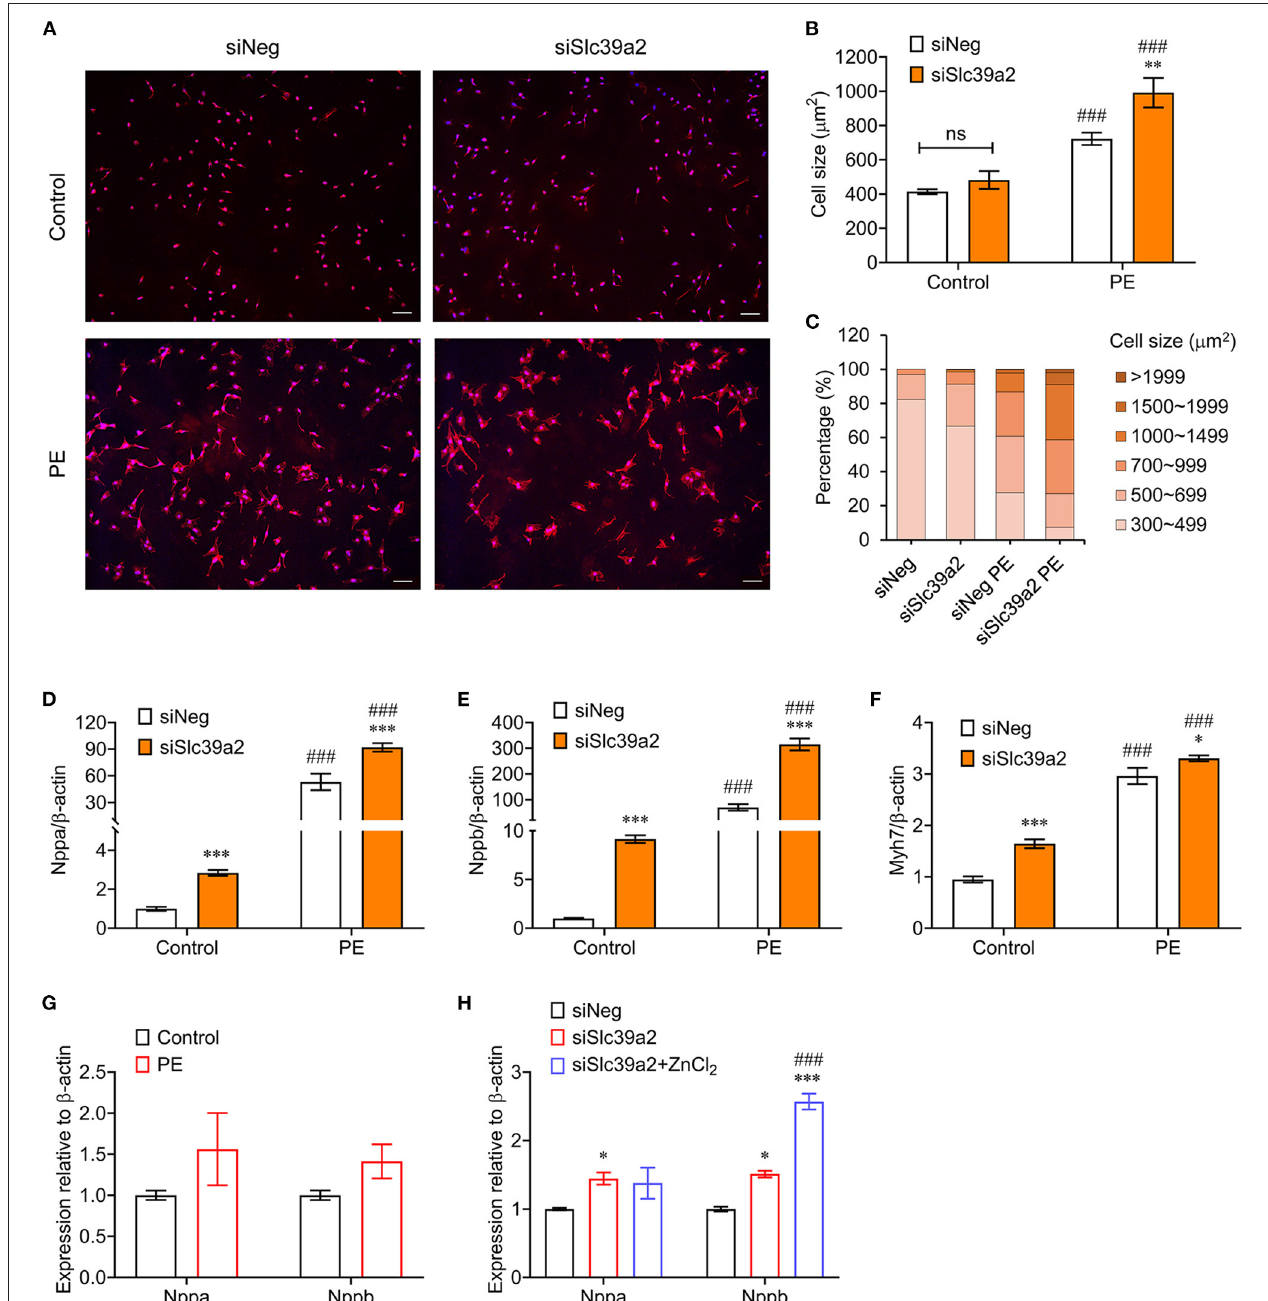
FIGURE 2 | Slc39a2 deficiency exacerbates PE-induced cardiomyocyte hypertrophy. (A) Representative images of WGA staining showing the impact of Slc39a2 knockdown on PE-induced cell size enlargement. Scale bar, 100 µ m. (B) Averaged cell size measured by WGA staining. **P < 0.01 vs. siNeg; ### P < 0.001 vs. Control. n = 3. (C) Counts of NRVMs with fragmented cell size range. (D–F) Impact of Slc39a2 on PE-induced hypertrophy markers, including Nppa (D) , Nppb (E) , and Myh7 (F) . * P < 0.05, *** P < 0.001 vs. siNeg; ### P < 0.001 vs. Control. n = 3. (G) qRT-PCR analysis for Nppa and Nppb with and without ZnCl 2 administration (10 µ M) in PE-treated NRVMs. n = 3. (H) Impact of zinc supplementation on NRVMs with or without Slc39a2 knockdown after PE treatment. * P < 0.05, *** P < 0.001 vs. siNeg; ### P < 0.001 vs. siSlc39a2. n = 3.